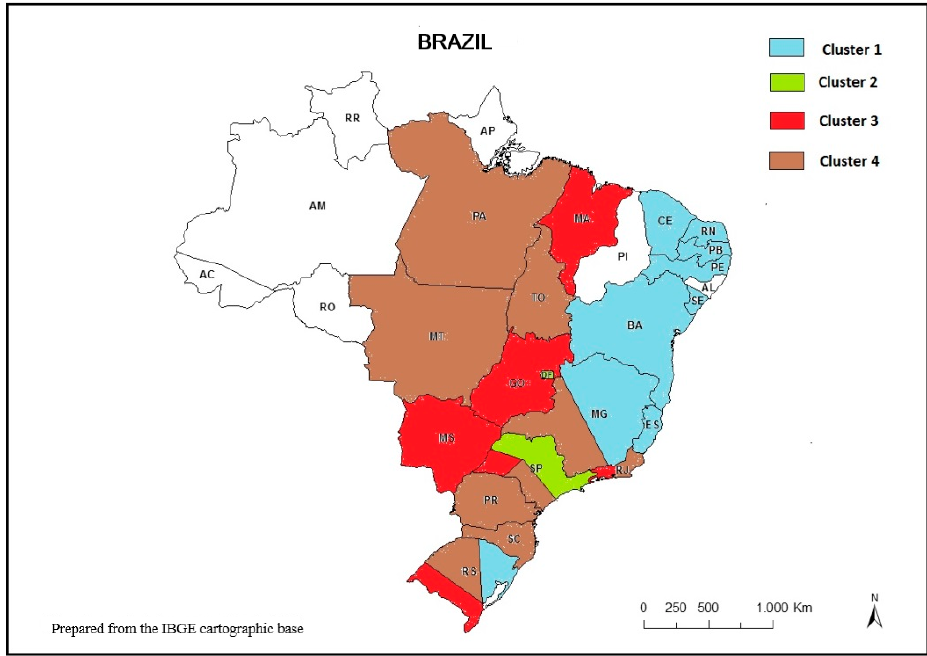
Figure 6. Cluster representation by area.